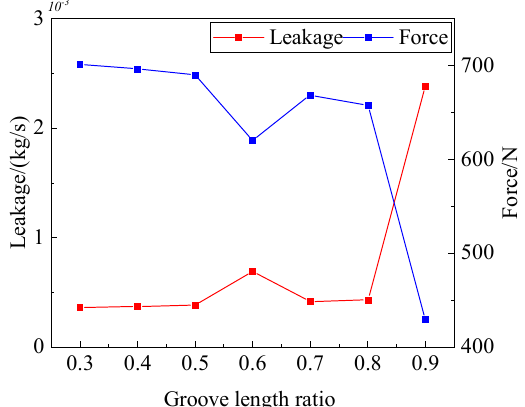
Figure 8. The effect of groove length ratio on leakage and force.